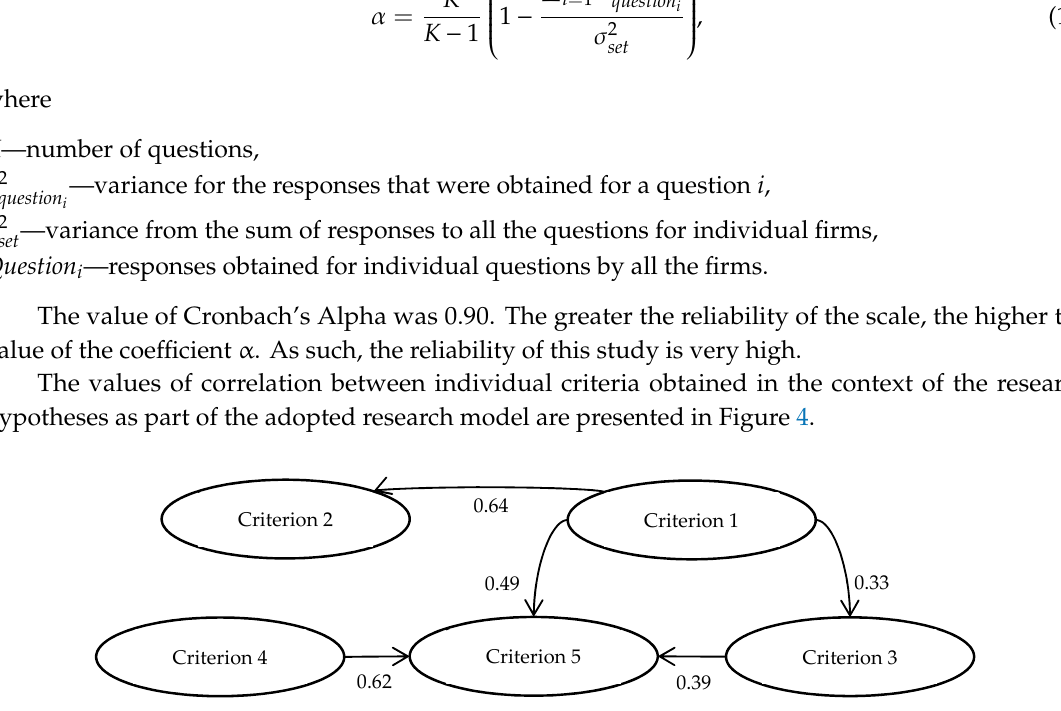
Figure 4. Graphical presentation of hypotheses together with values of correlation between the examined variables.